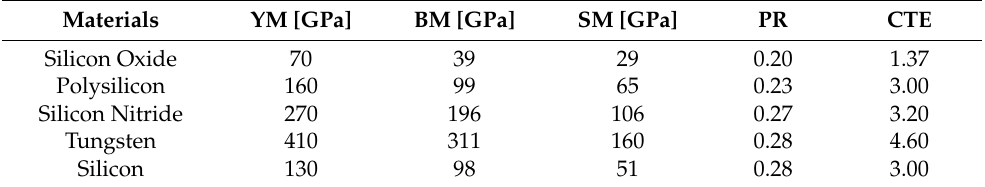
Table 1. Mechanical parameters used in the 3D NAND simulation. The Young’s modulus (YM), bulk modulus (BM), shear modulus (SM), Poisson’s ratio (PR), and coefficient of thermal expansion (CTE) were used to calculate the mechanical stress simulation.